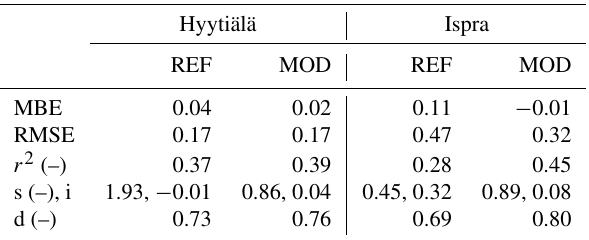
Table A3. As in Table A2 but for V d (O 3 ) (in centimeters per sec- ond; cms − 1 ).